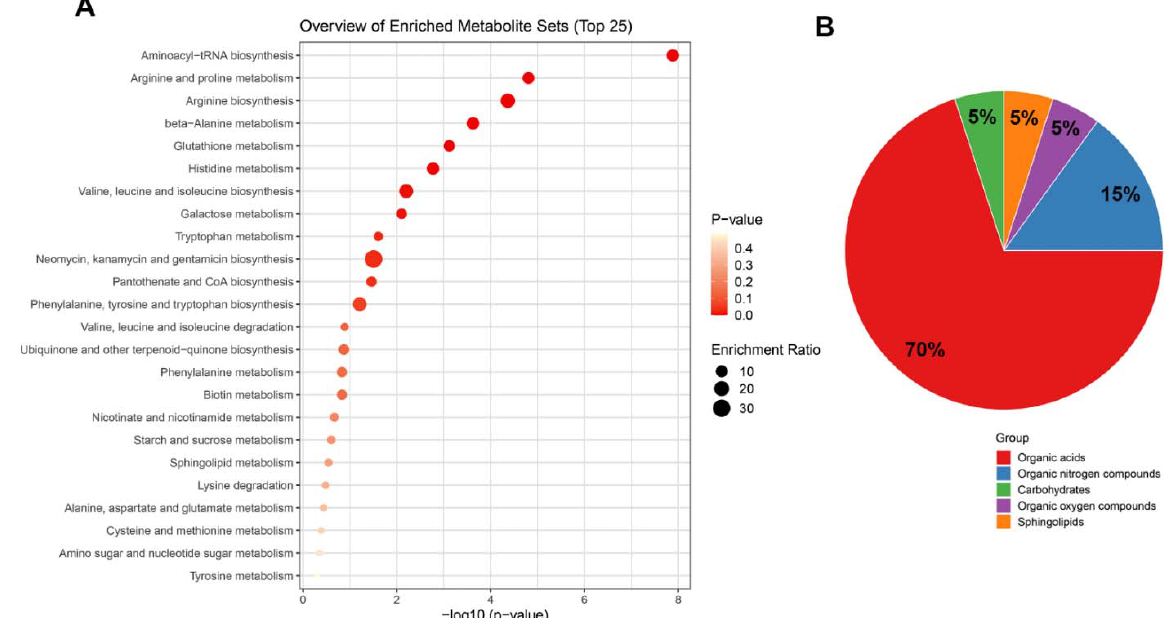
Figure 8. Top enrichment analysis of the metabolites modified by melatonin. ( A ) All metabolites were used to enrich terms based on KEGG metabolic pathways. ( B ) Pie chart showing the most representative chemical class metabolite sets. Analysis was performed in MetaboAnalyst v.5.0 using the metabolites within the Human Metabolome Database HMDB, and showed significant alteration in many pathways in a triple negative MD-MBA-231 breast cancer xenograft model.